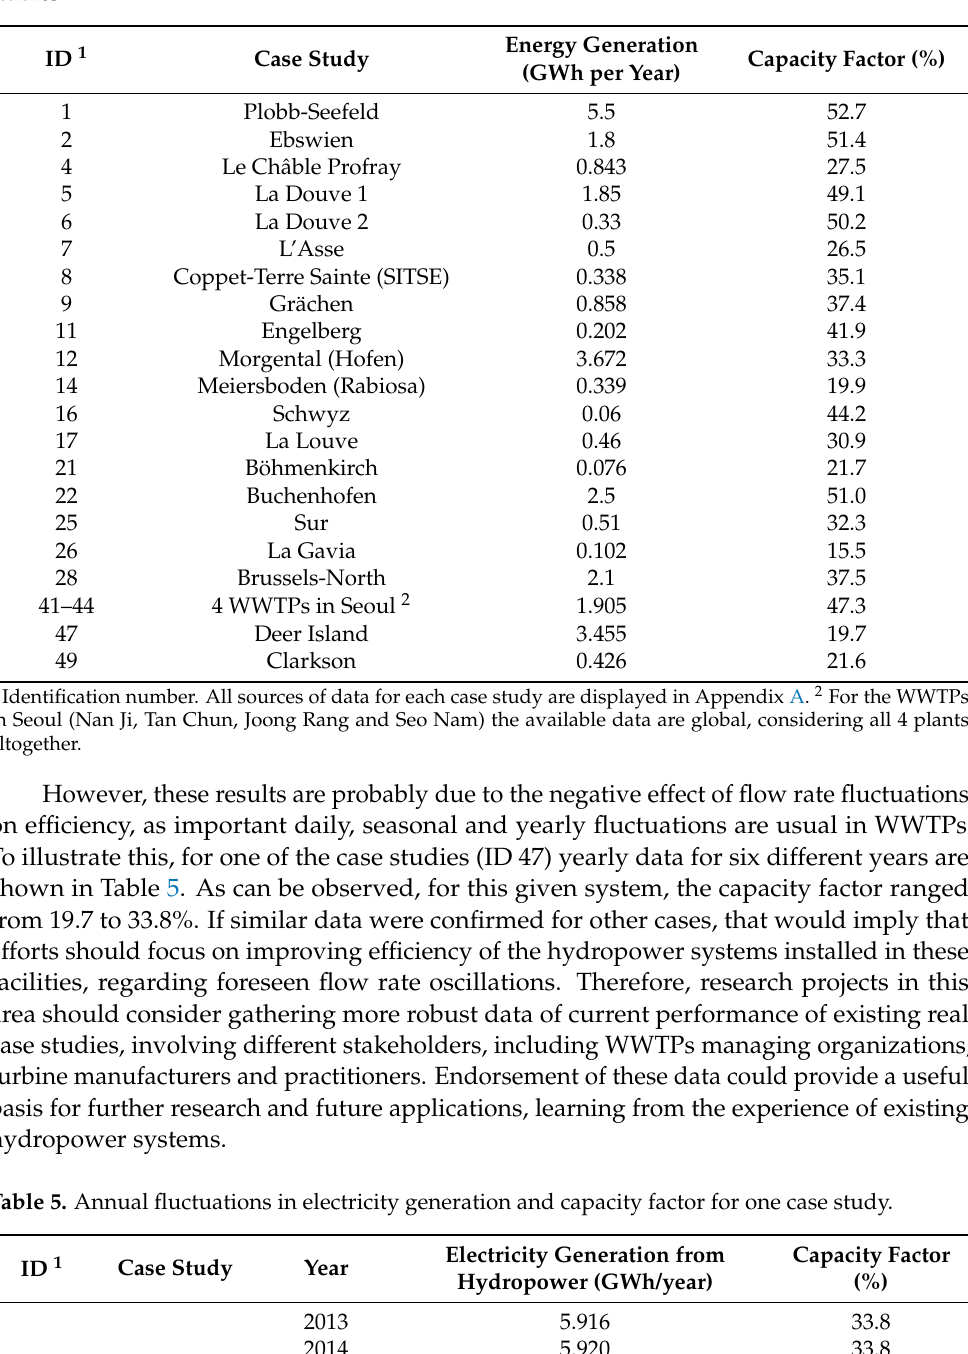
Table 4. Electricity generation and capacity factor of hydropower systems installed in real cases studies.